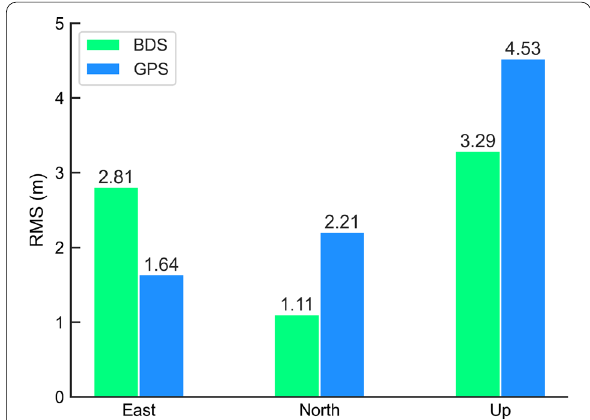
Fig. 21 Kinematic smartphone positioning bias RMS of BDS and GPS with respect to the BDS/GPS combination